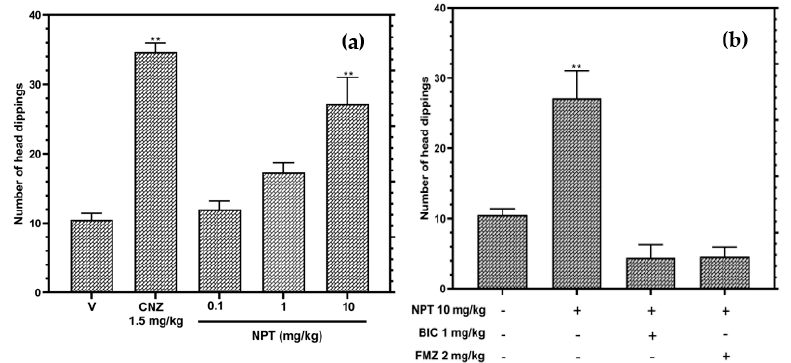
Figure 4 . Anxiolytic-like actions of NPT (0.1–10 mg/kg p.o.) in the HBT ( a ), and the possible anxiolytic mechanism of NPT ( b ). Bicuculline (BIC) and flumazenil (FMZ) were used as antagonists. The reference drug was 1.5 mg/kg p.o. clonazepam (CNZ). The results of all experimental groups are reported as the mean values (±SEM). n = 8, ** p < 0.05 regarding to the vehicle group (indicated as V).